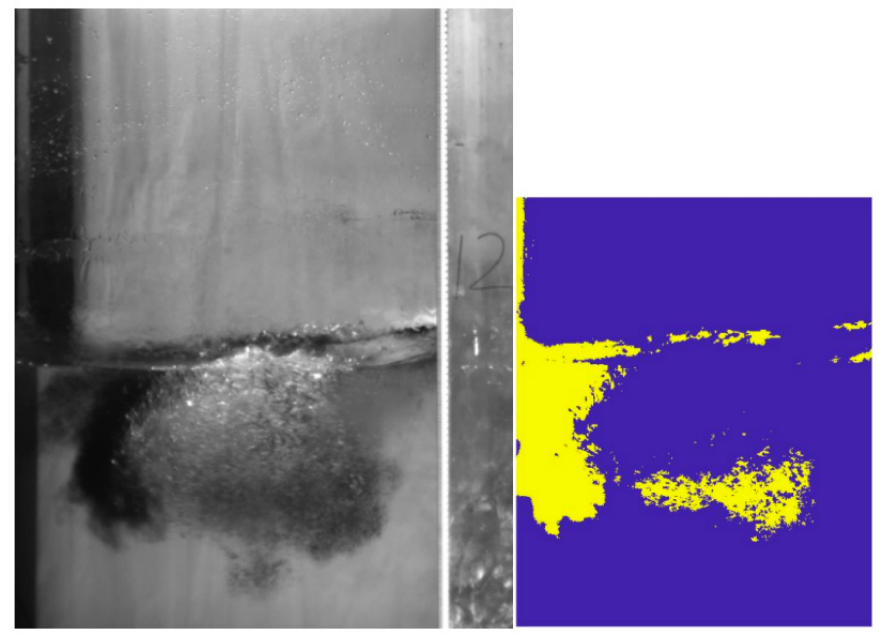
Figure 7. Spilled oil in the deepest position of the observation area under a 15 cm breaking wave.